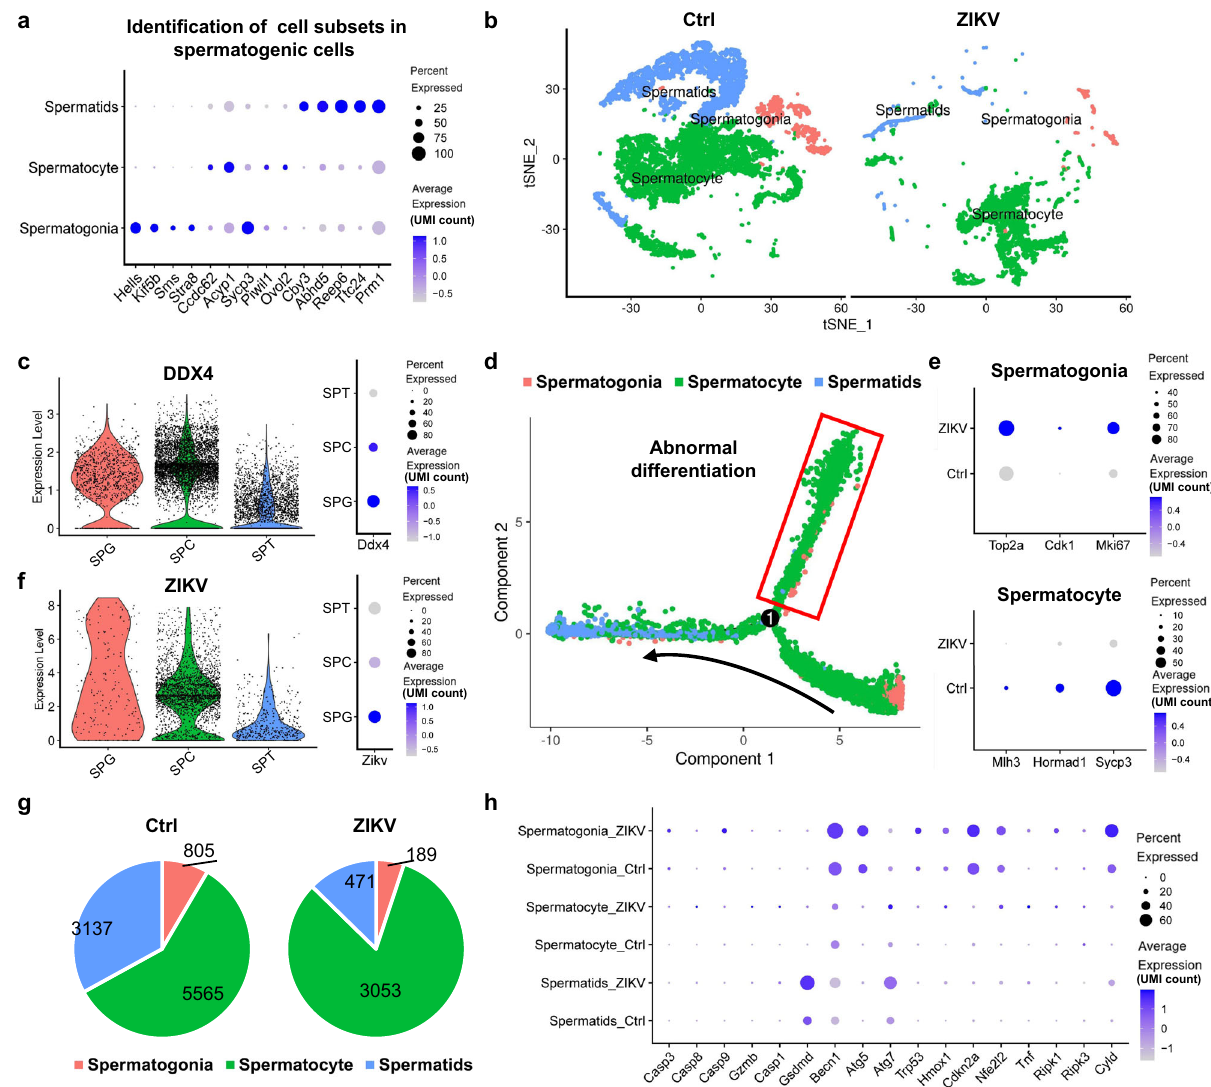
Fig. 2 | Characterization of spermatogenic cells in control and ZIKV-infected testesbySingle-cellsequencing.a Spermatogeniccells inthe testesfrom control and ZIKV-infected mice were sorted into spermatogonia, spermatocyte, and sper- matids subsets. The expression of spermatogenic maturity-related genes were shown in bubble chart. b The distribution of spermatogonia, spermatocyte, and spermatids were shown in tSNE chart. c The expression of DDX4 gene in sperma- togonia (SPG), spermatocyte (SPC), and spermatids (SPT) subsets were shown in violin plot and bubble chart. d Pseudotime analysis of spermatogonia, spermato- cyte, and spermatids in the testes from control and ZIKV-infected mice. The curve witharrowheadshowedthedifferentiationincontroltestes.Cellsshownwithinred